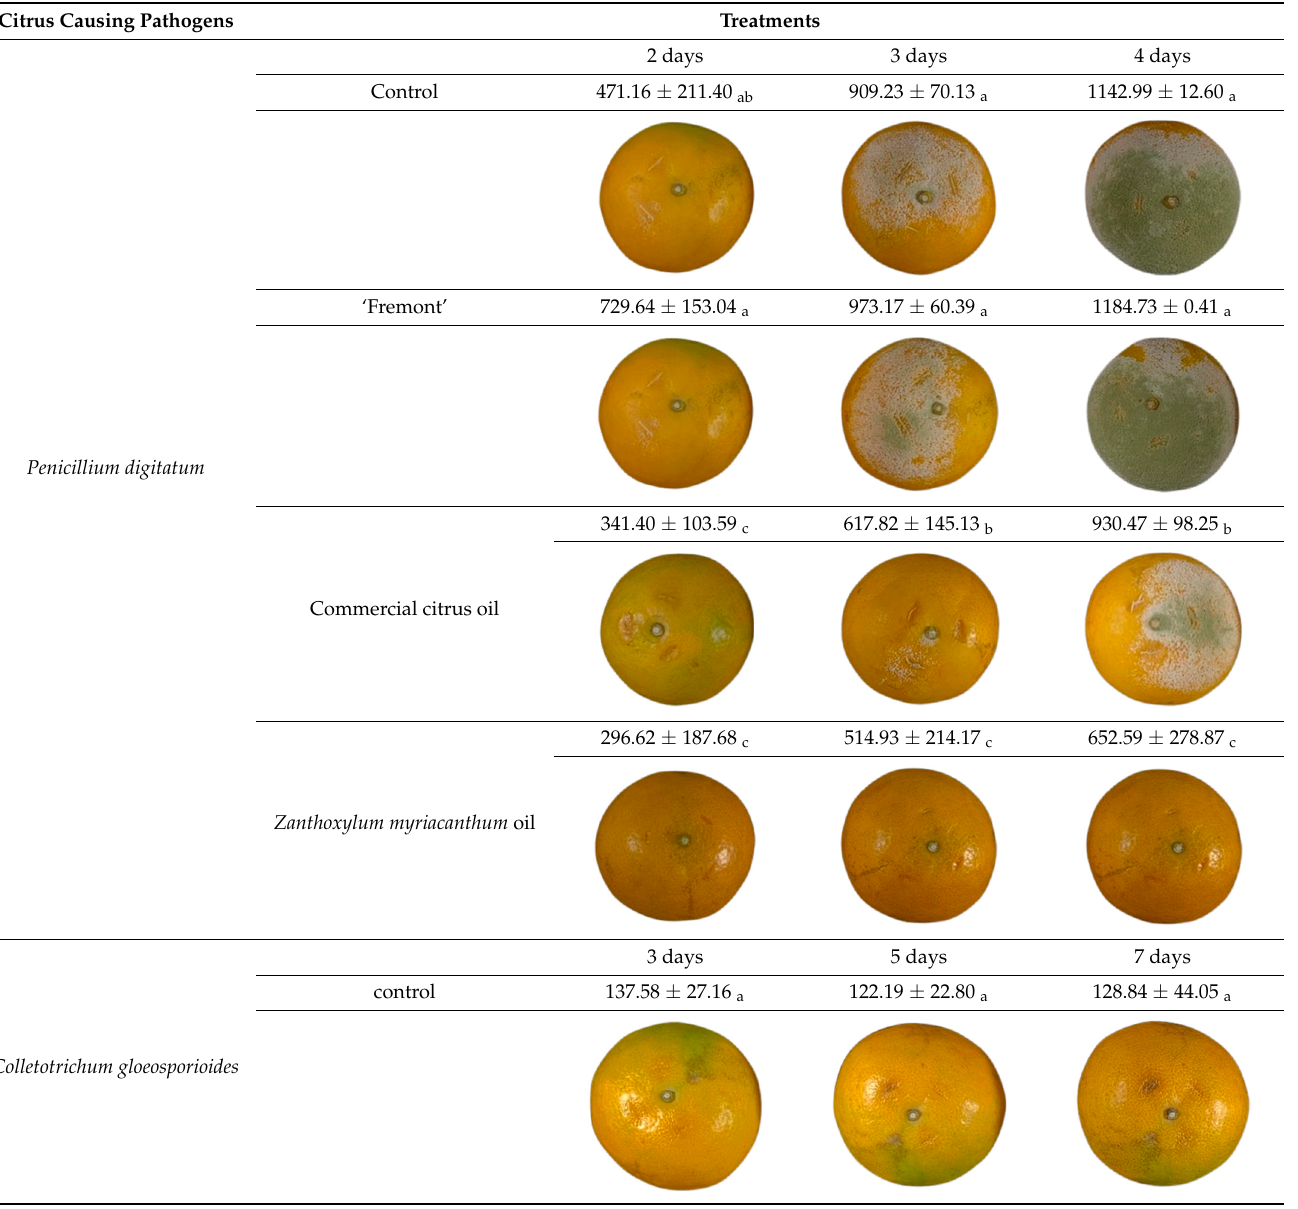
Table 4. The lesion size (mm 2 ) of pathogens ( Penicillium digitatum and Colletotrichum gloeosporioides )